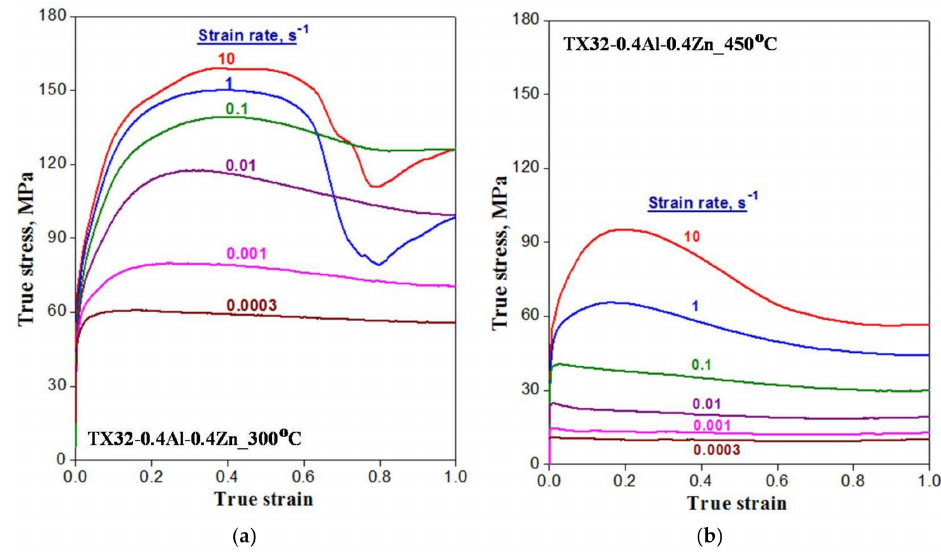
Figure 6. True stress–true strain plots obtained in compression for six strain rates at ( a ) 300 ◦ C and ( b ) 450 ◦ C.